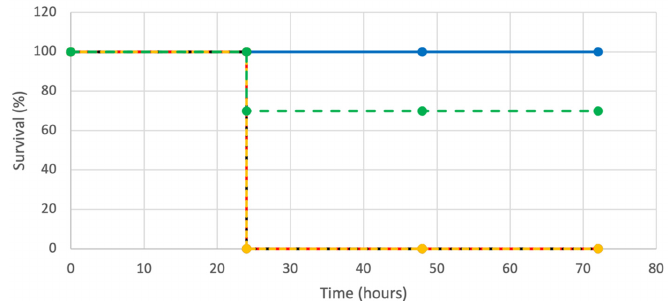
Figure 7. Kaplan–Meier survival curves for G. mellonella following injections of P. aeruginosa PAO1, with LL-37 and PMB, alone or in combination. One hundred twenty-five G. mellonella were injected with 5.0 × 10 1 P. aeruginosa PAO1 cells. After 20 min at 4 °C, the G. mellonella were injected with LL-37 and PMB, alone or in combination. Twenty-five G. mellonella were injected for each condition with the following antimicrobial agent concentrations: 32 μ g/mL LL-37 (black, dotted line), 0.25 μ g/mL PMB (yellow, dotted line), and 0.25 μ g/mL PMB + 32 μ g/mL LL-37 (green, dotted line). Twenty-five G. mellonella were included in control conditions of 5.0 × 10 1 P. aeruginosa PAO1 cells in the absence of PMB injection (red, dotted line), and PBS injection with neither bacterial cells nor PMB injections (blue, solid line). The survival of the worms was evaluated every 24 h for 72 h.